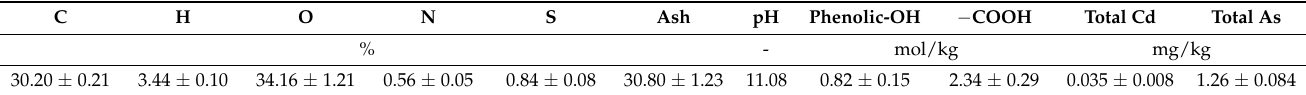
Table 1. Physical and chemical properties of the Ca-humic